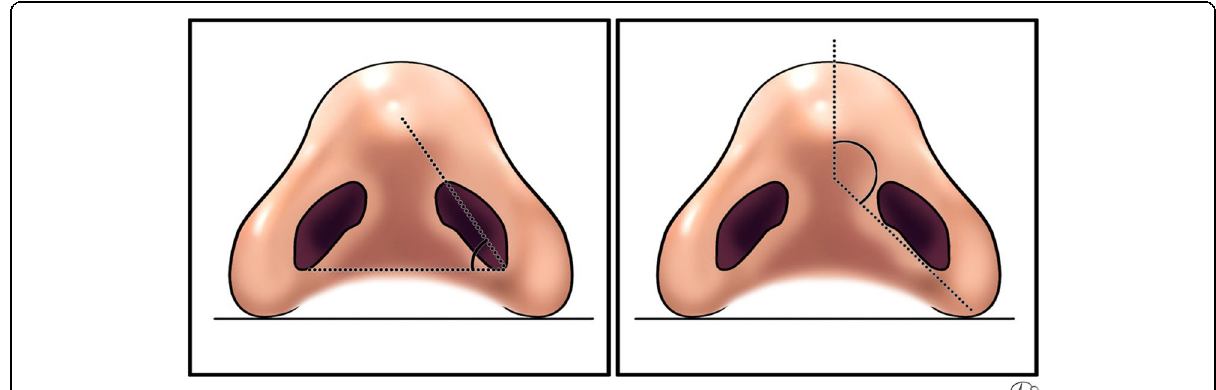
Fig. 11 a The angle between the longitudinal nostril axis and the horizontal plane and b the angle between the line along with the medial inclination of the nasal sill and the sagittal plane. These angles can be considered and recorded in the patient ’ s preoperative analysis